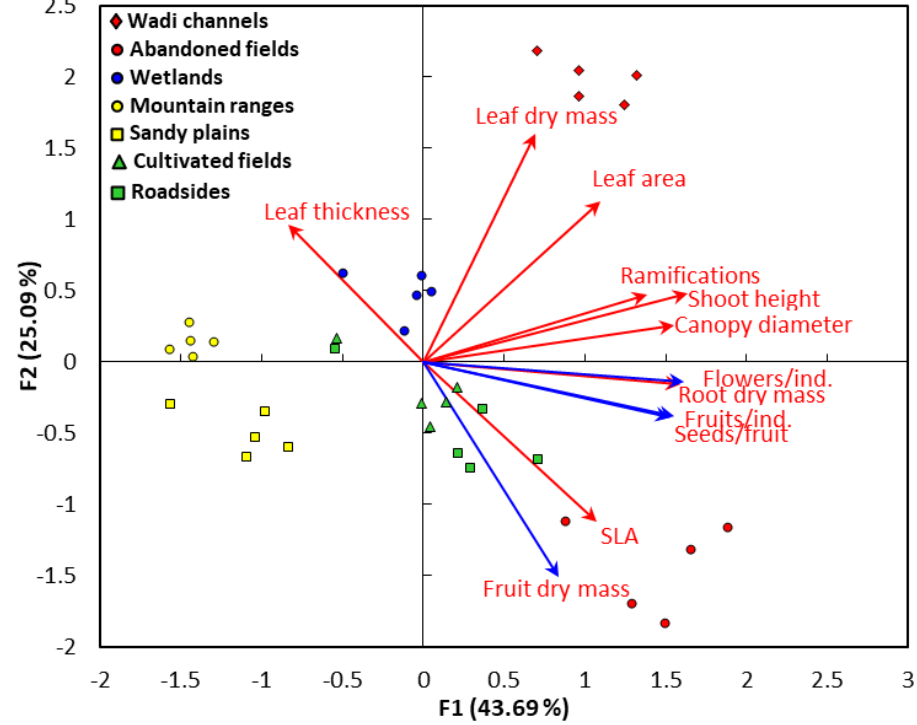
Figure 3. The principal component analysis (PCA) between the functional traits and different habitats of Argemone ochroleuca . The vegetative (red vectors) and reproductive (blue vectors) traits. SLA: specific leaf area.